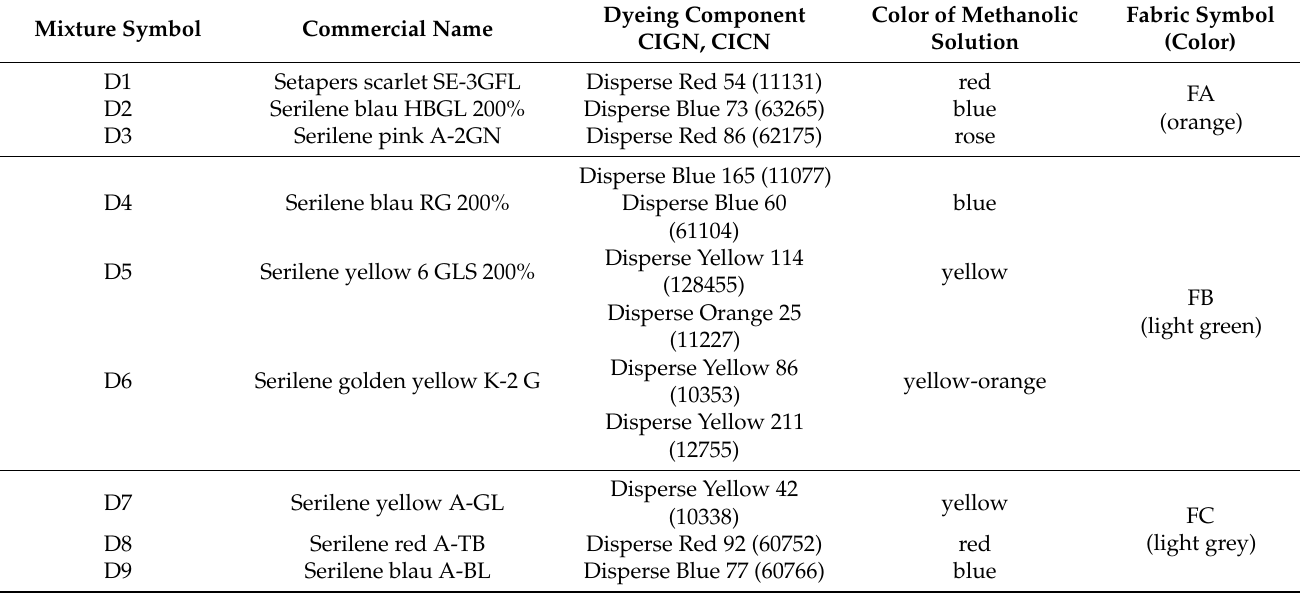
Table 6. Commercially available dyeing mixtures used in experiments.